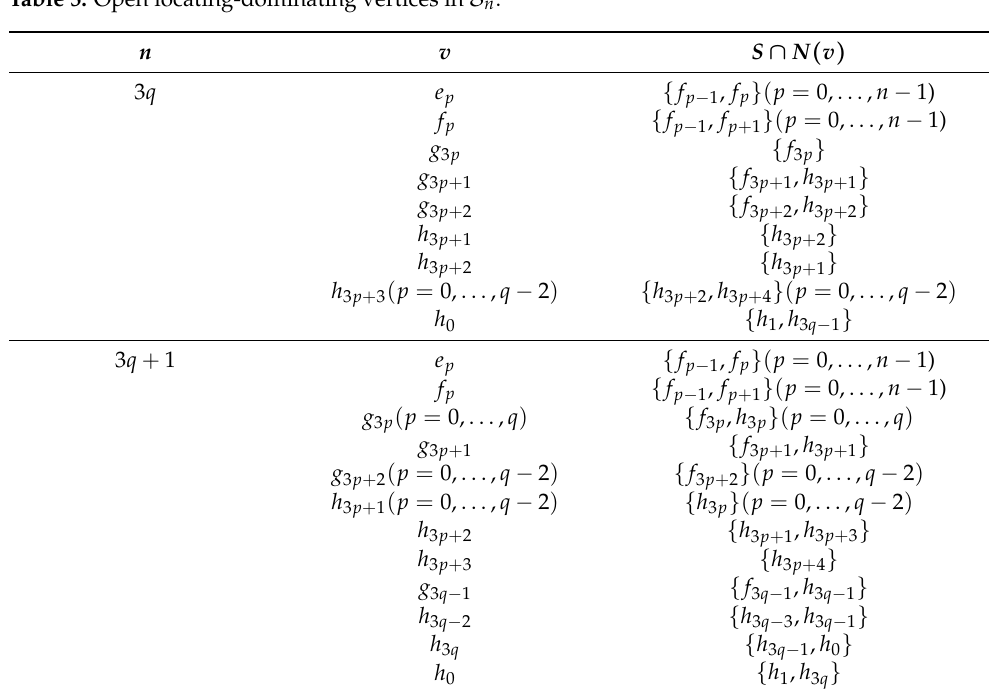
Table 5. Open locating-dominating vertices in S n